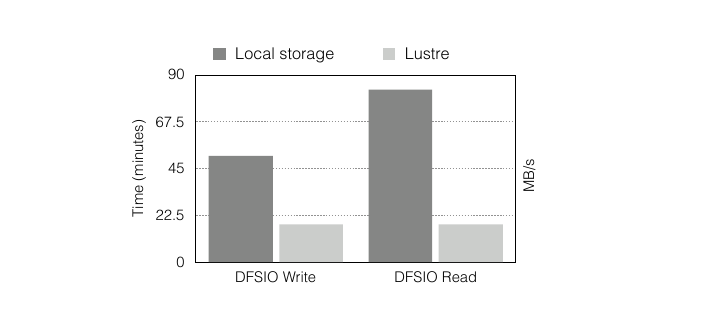
using local disk for small number of servers. Figure 2. IOzone benchmark results for four di ff erent data throughput tests (read, reread, write and rewrite). Results are in MB / s, Higher throughput indicates better performance. Lustre (light gray) is consistently better than local disks (dark gray). IOZONE test showing higher throughput with Lustre than with three nodes using 3 local disk per node.